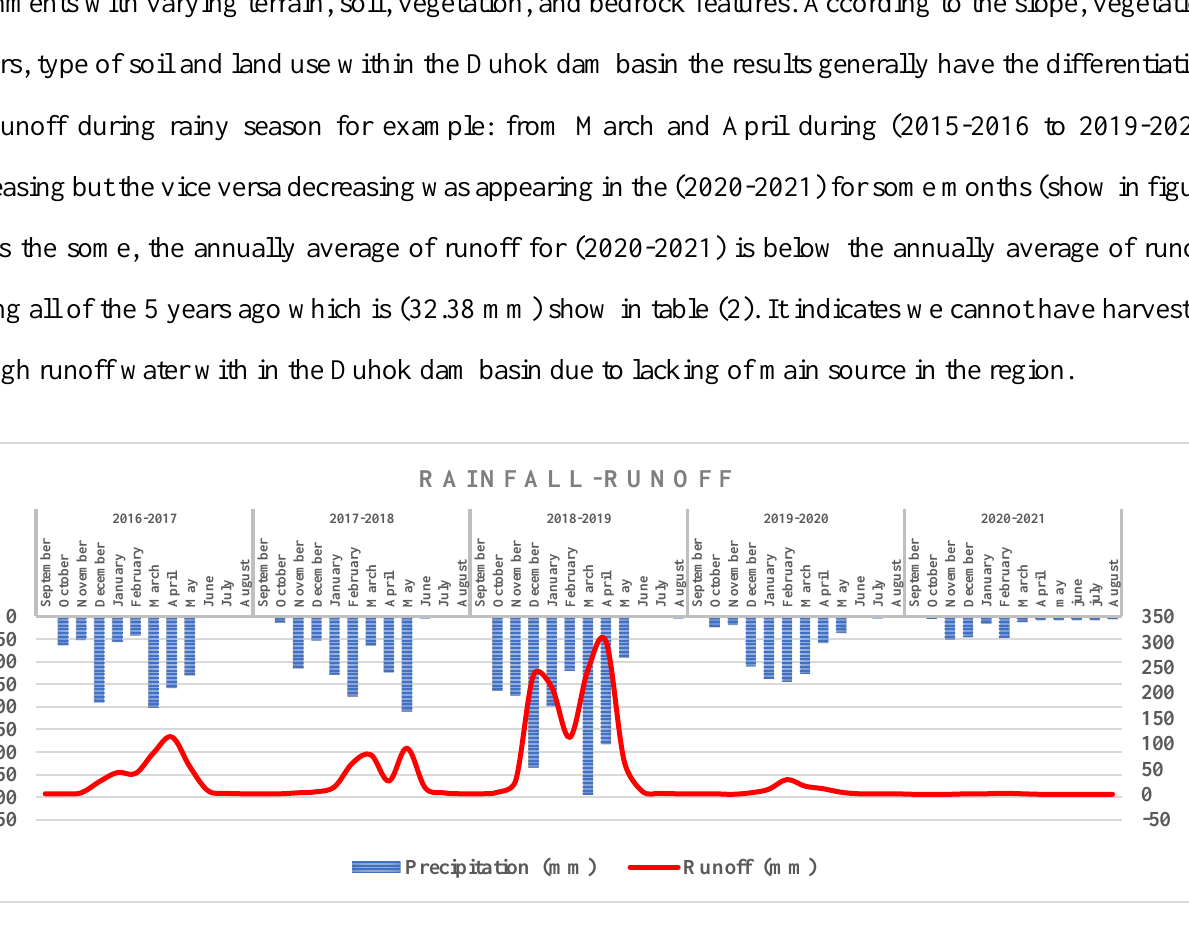
Figure 6 . The rainfall-runoff